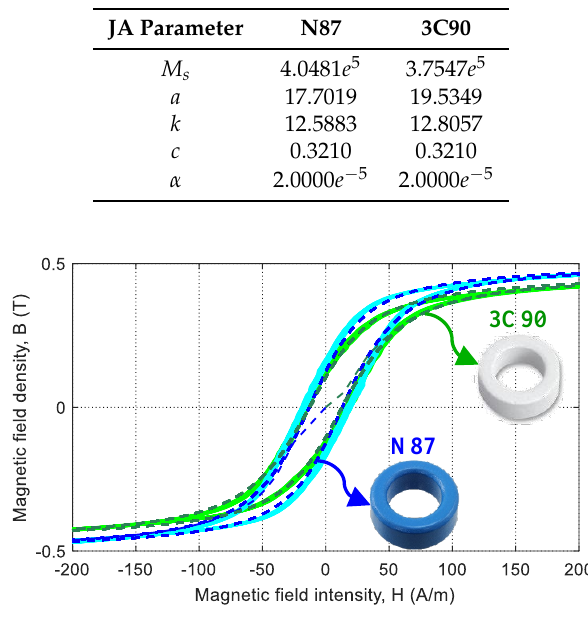
Figure 7. Model (dotted line) versus experimental (solid line) B ( H ) curves for two different magnetic materials: N87 (blue) and 3C90